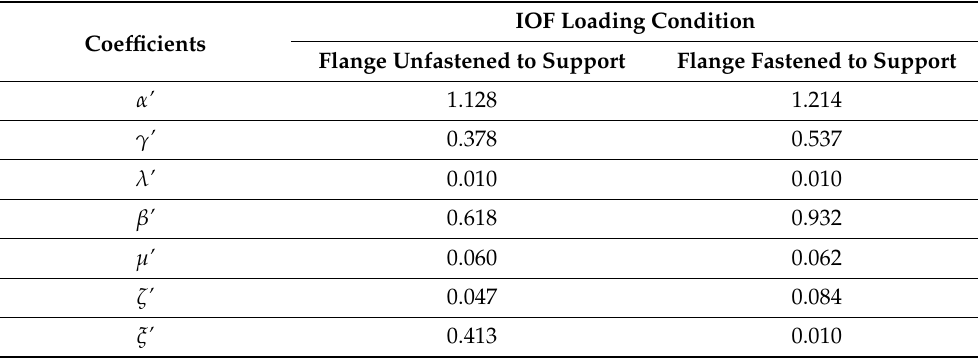
Table 5. Proposed equations summary for the web crippling strength reduction